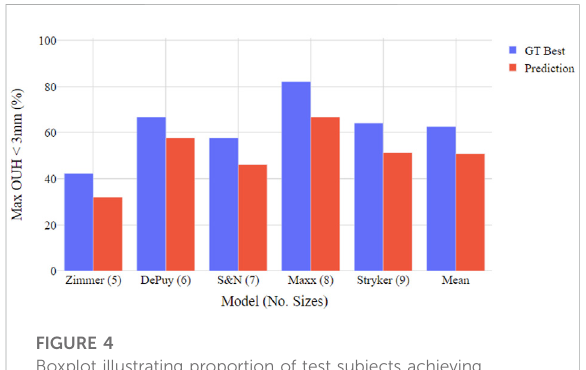
FIGURE 4 Boxplot illustrating proportion of test subjects achieving maximum OUH < 3 mm for various femur component model sizings. Both ground truth (GT) best possible size and tool prediction results shown.